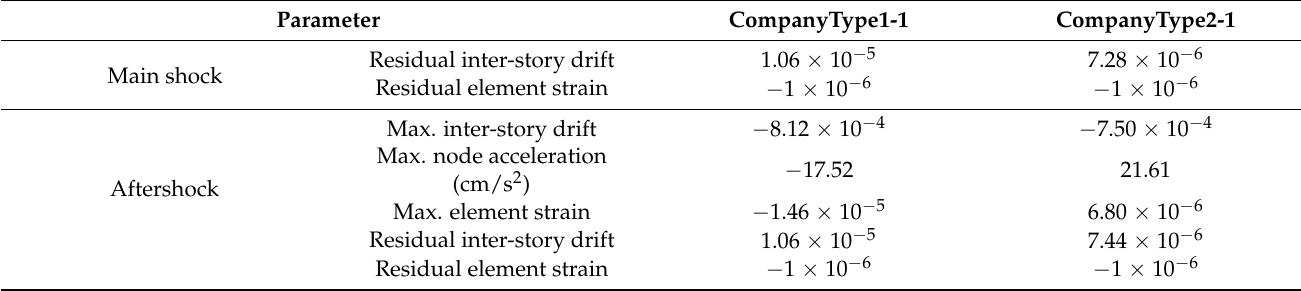
Table 4. Response values that are assumed to be measured by